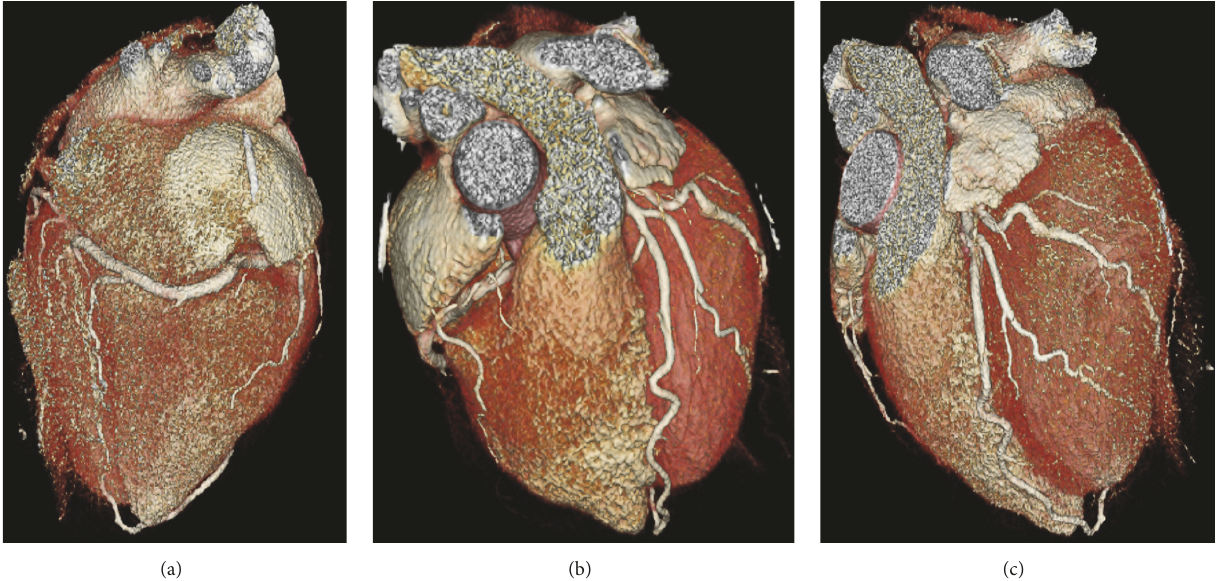
Figure 3: Coronary CT views: (a) left ventricle being supplied by branches of the RCA, (b) LAD in the interventricular groove, and (c) absent left circumflex